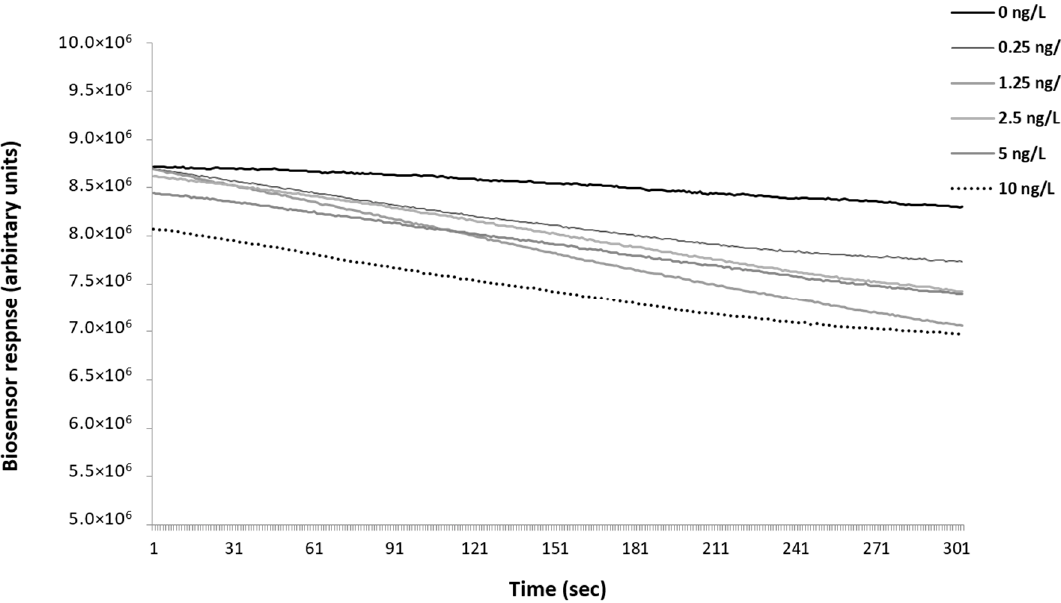
Figure 3. Representative patterns of time-dependent bioelectric responses of Vero cells membrane-engineered with the anti-TCA antibody against increasing concentrations of 2,4,6-trichloroanisole (2,4,6-TCA) spiked in TCA-free oak barrel water extract. Note the increasing cell membrane hyperpolarization (decline to negative values) with increasing 2,4,6-TCA concentrations.